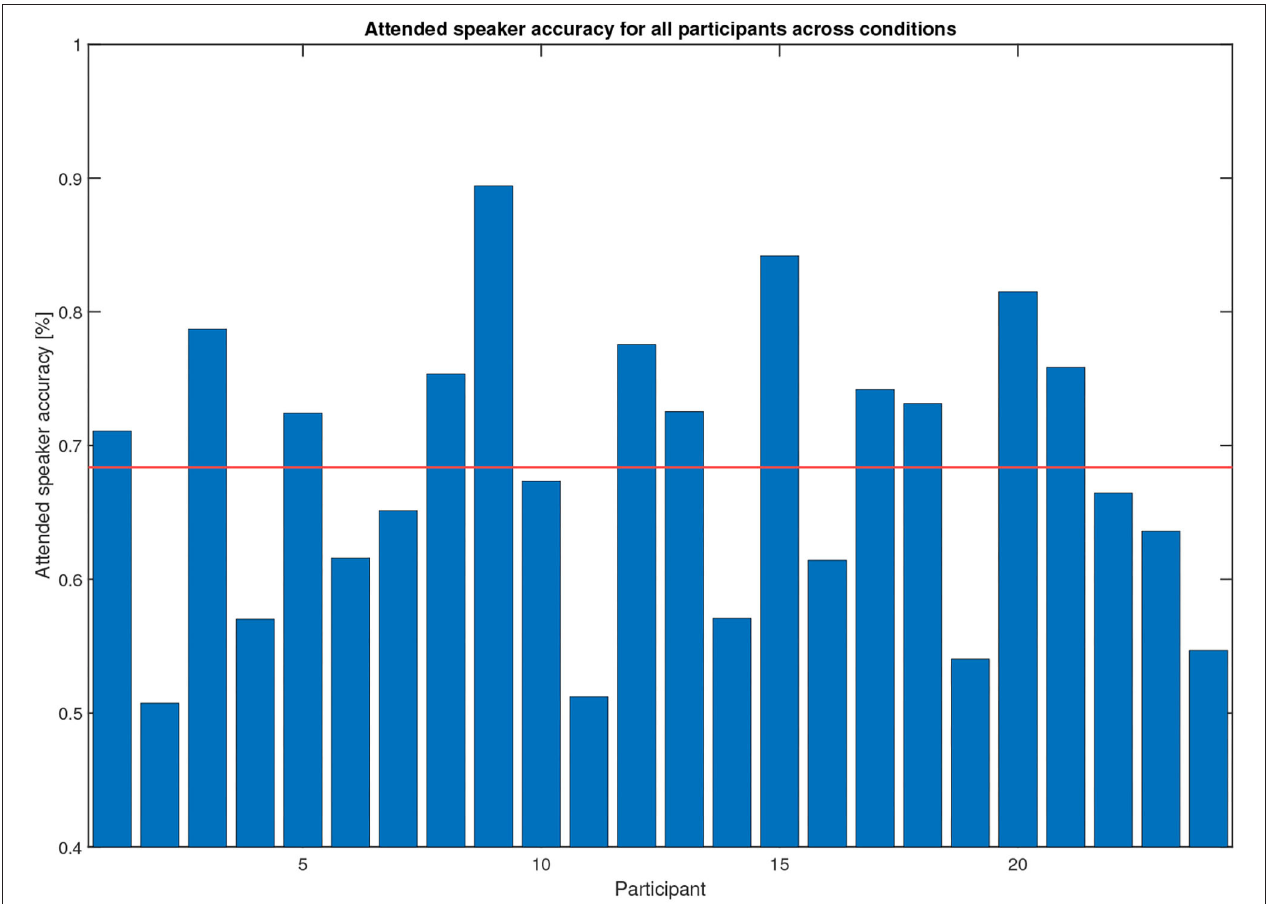
FIGURE 8 | Attended speaker true accuracy across all conditions for the 25 participants (only 24 shown due to missing reference data for one participant). The mean of the true accuracy across participants is 68%. These data were computed during the experiment.